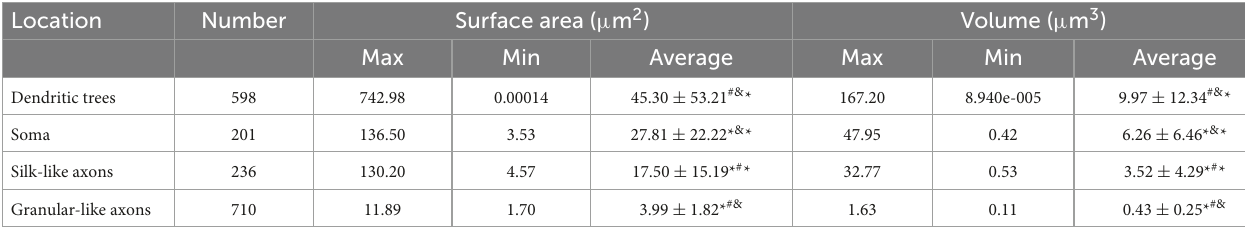
TABLE 1 Analysis of mitochondrial meshes in different subcellular units of PC in PCs-Mito-GFP mice. Location Number Surface area ( µ m 2 ) Volume ( µ m 3 ) Min